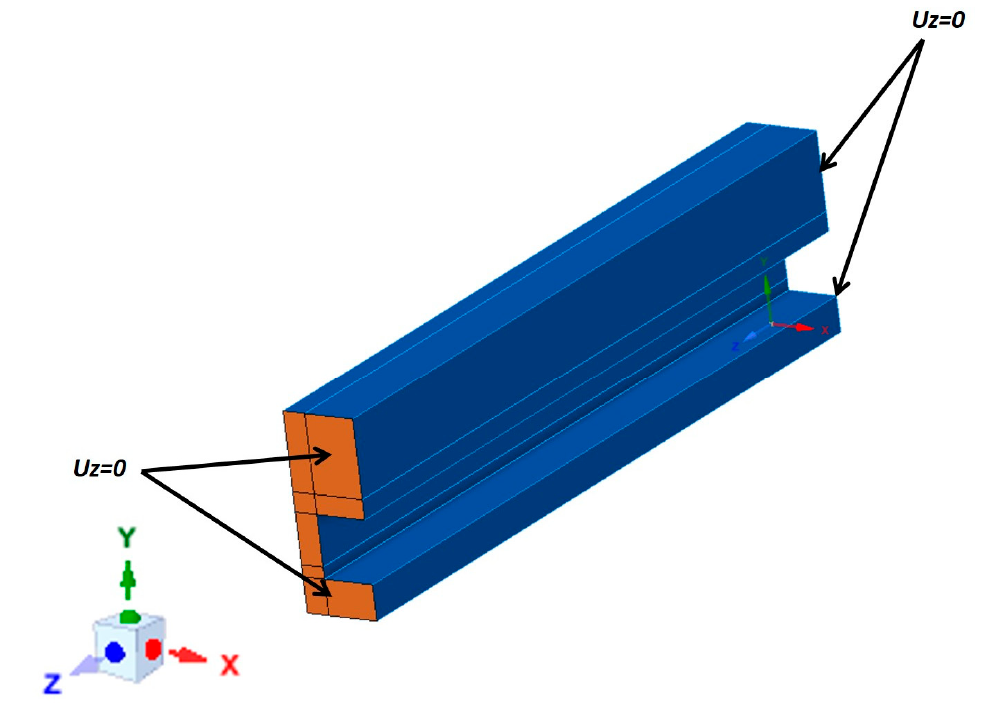
Figure 6. Three–dimensional model.